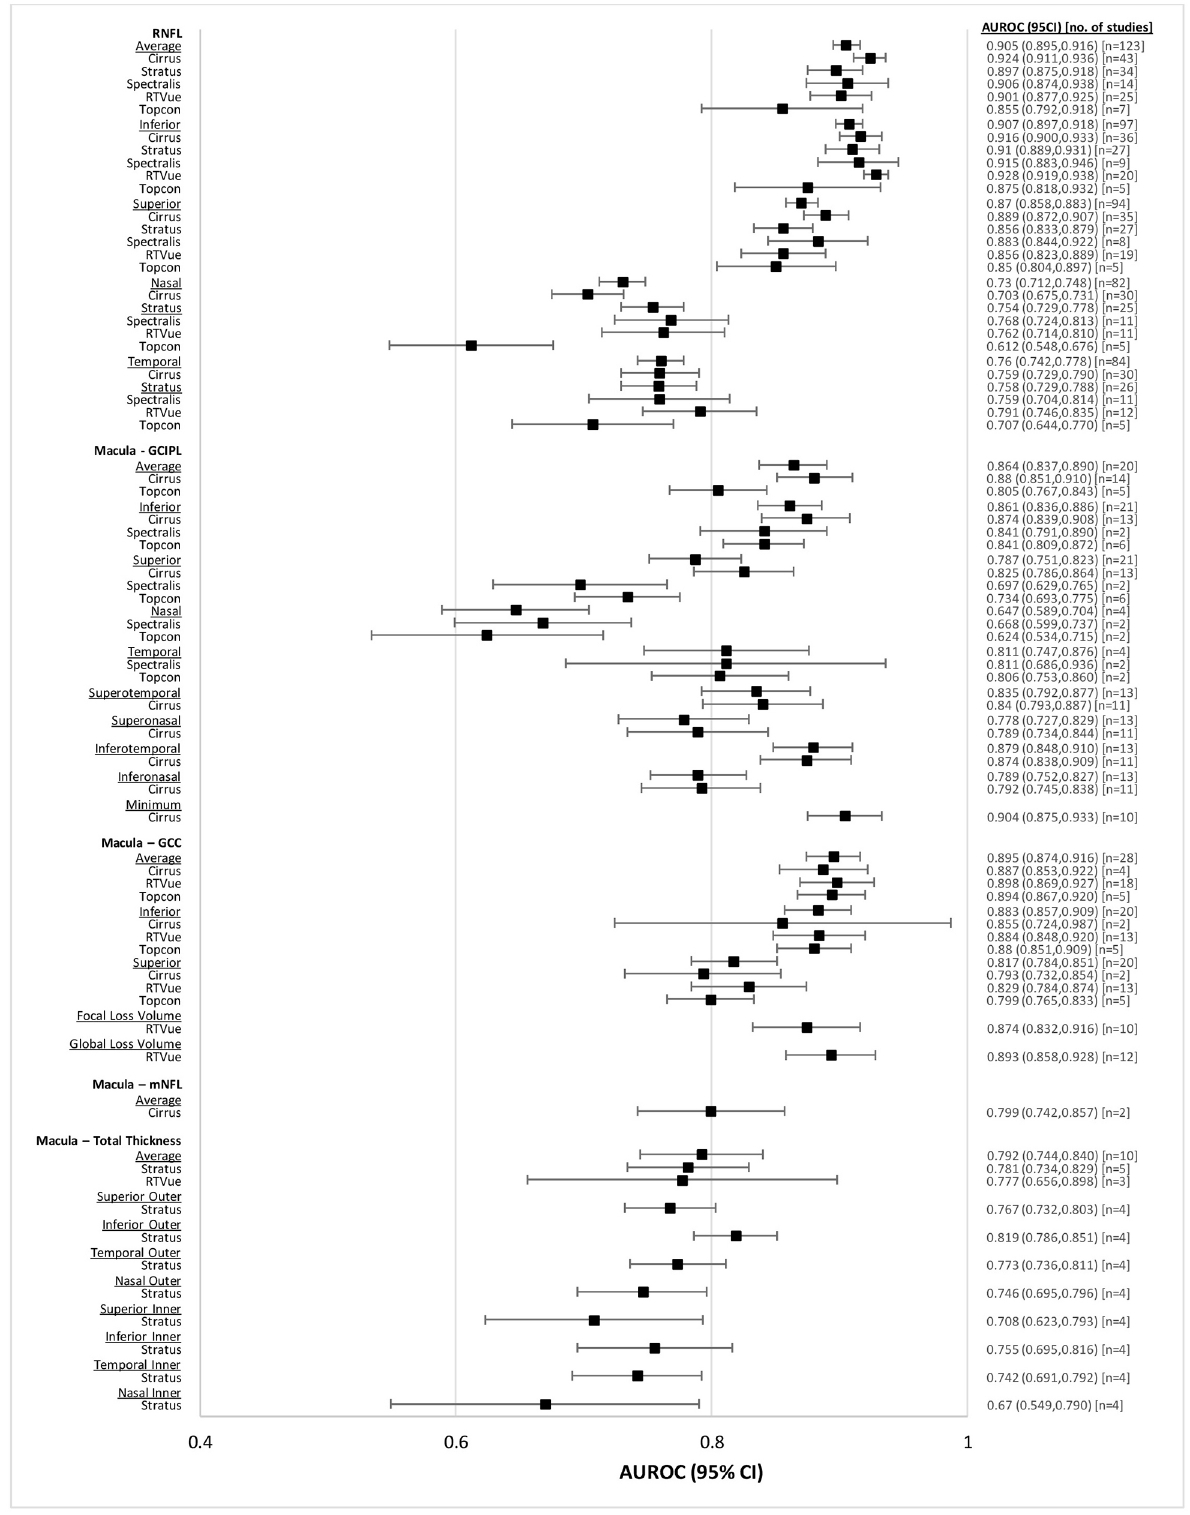
Fig 4. Forest plot of diagnostic accuracies of RNFL and macular OCT parameters,perimetric glaucoma.